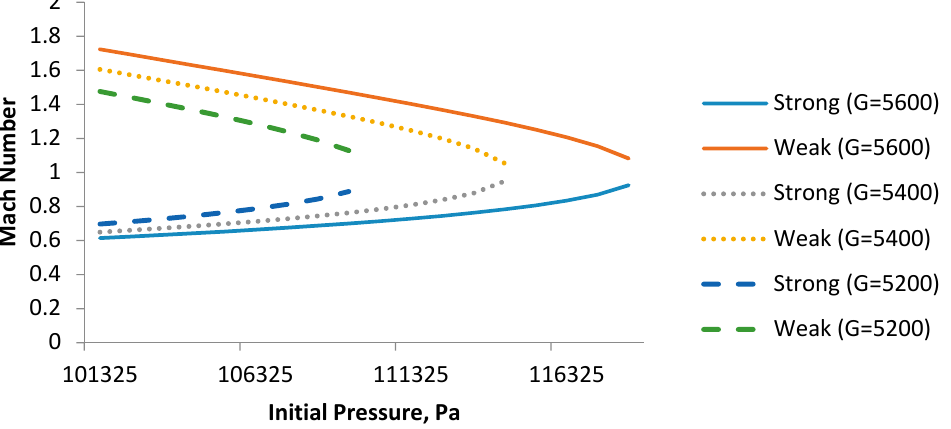
Figure 7. The influence of initial pressure and mass flux on the Mach number for Algae Biofuel (T = 2000 K).